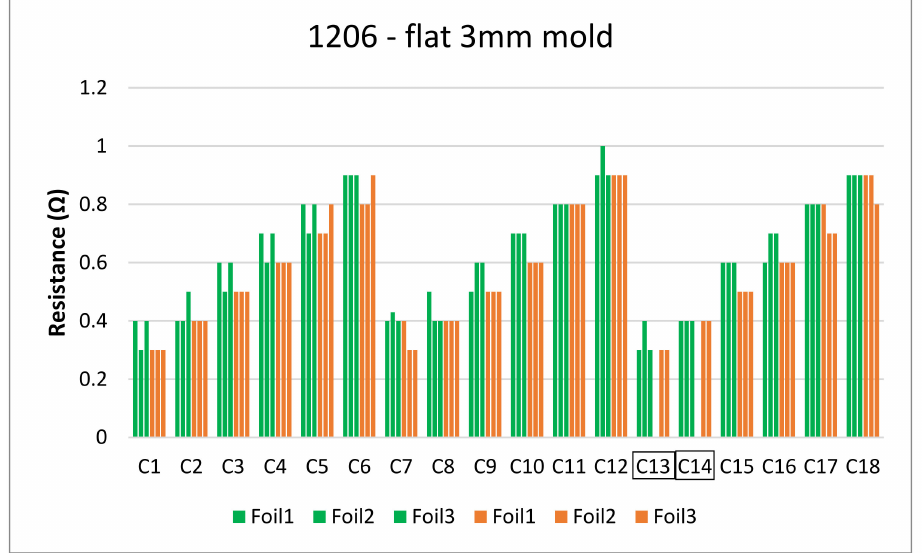
Figure 41. Resistance measurements for flat mold-3 mm for 1206 resistors.